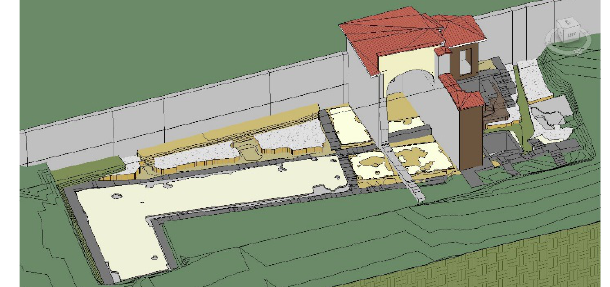
Figure 6: view of the whole model of the actual state of the archaeological area, without the temporary structure of